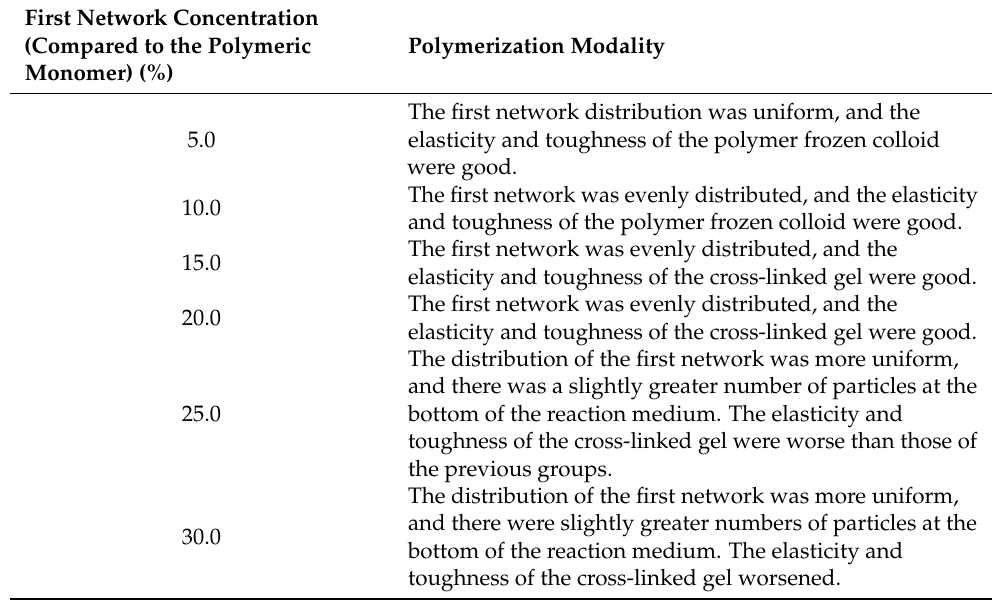
Table 4. Morphologies of the interpenetrating polymer networks prepared using different concentra- tions of the first network